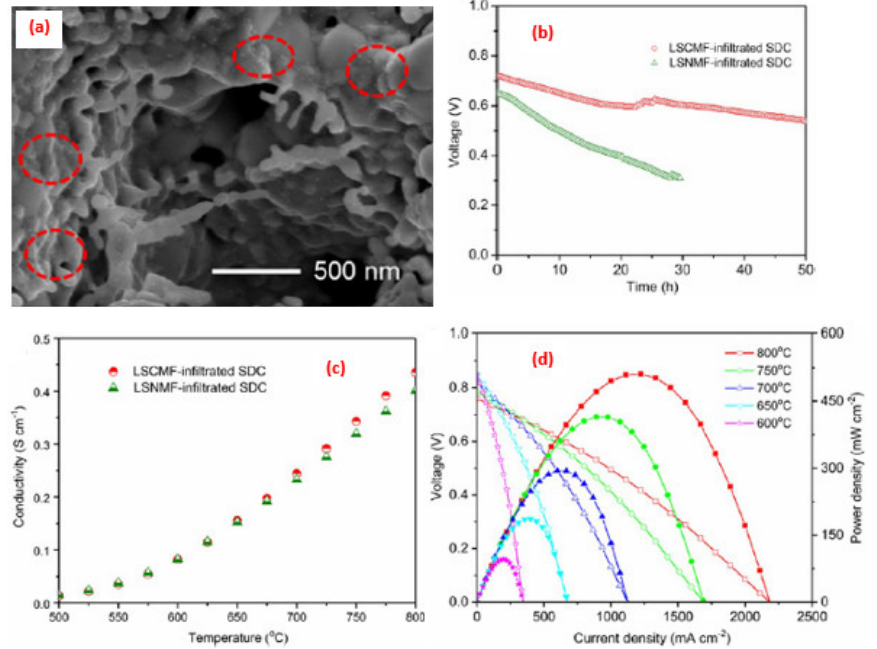
Figure 7. ( a ) EM image of FeCo alloy and LSMF nanoparticles; ( b ) I – V and I – P curves of the fuel cells with reduced La 0.6 Sr 0.4 Co 0.2 Mn 0.2 Fe 0.6 O 3 − δ -infiltrated Sm 0.2 Ce 0.8 O 1.9 200 ppm of H 2 S-H 2 at 600–800 ◦ C; ( c ) electrical conductivities of the reduced LSCMF and La 0.6 Sr 0.4 Ni 0.2 Mn 0.2 Fe 0.6 O 3 − δ -infiltrated SDC anodes in 10 vol% H 2 –Ar at 500–800 ◦ C; and ( d ) stability tests of the single cells with FeCo/RP-La 1.2 Sr 0.8 Mn 0.4 Fe 0.6 O 4 − δ and FeNi/RP-LSMF infiltrated SDC anodes operating at 200 ppm. Copyright